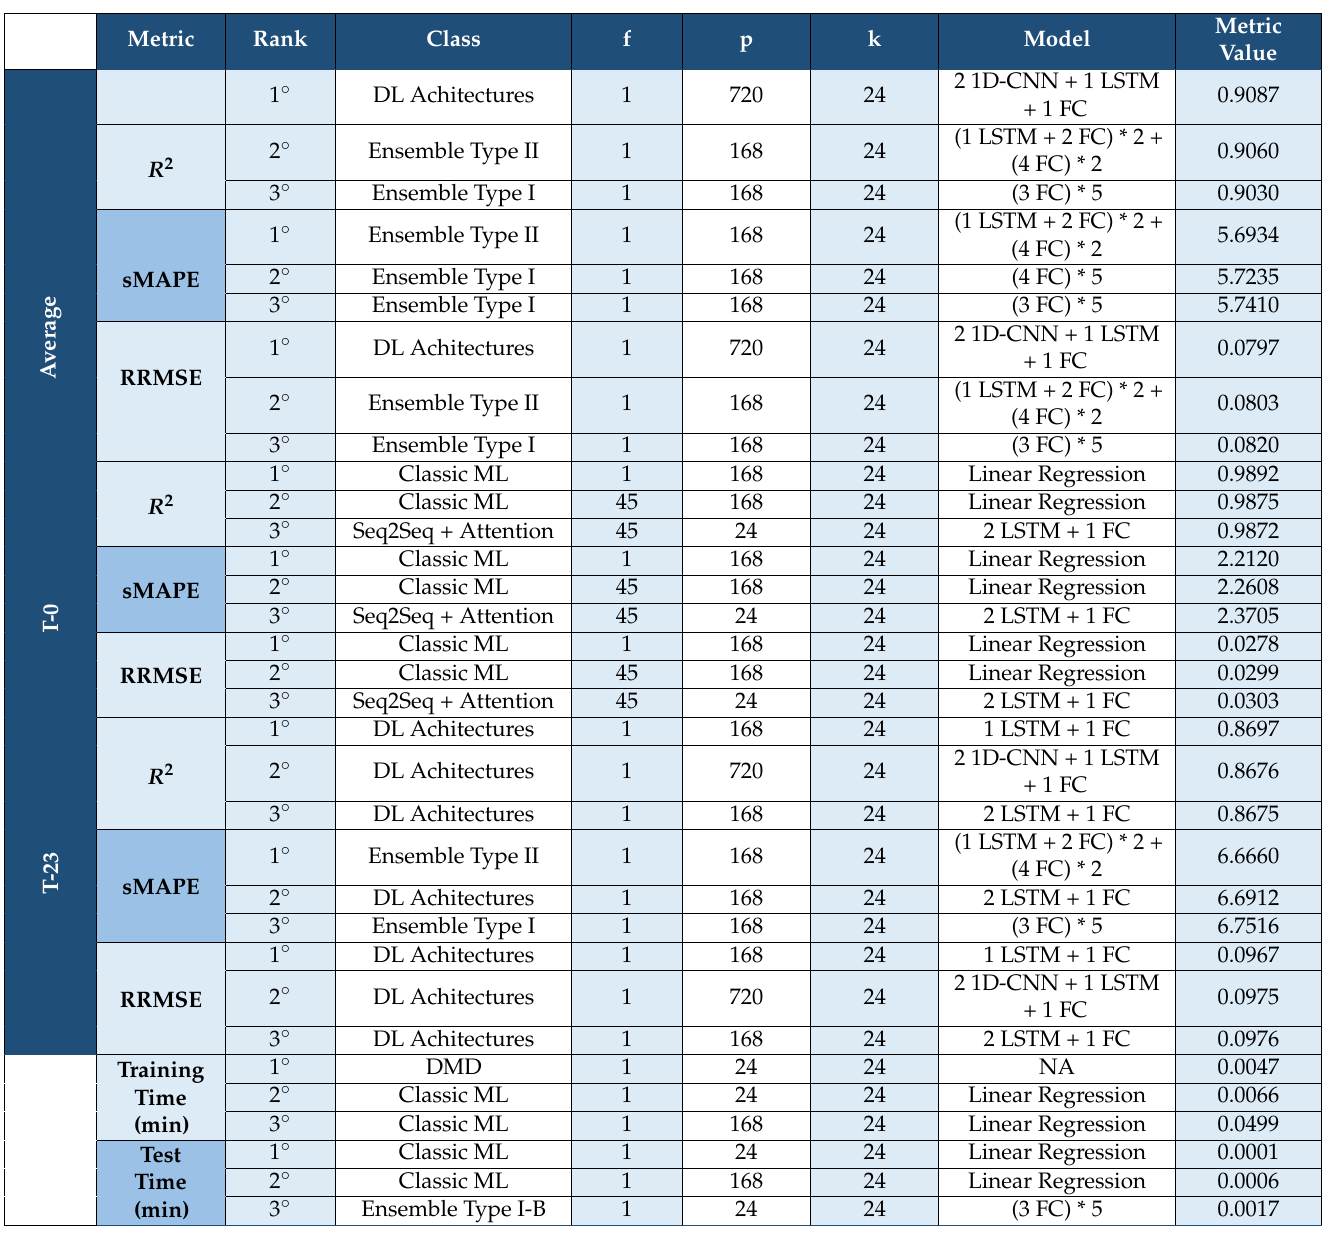
Table 1. Ranking of the three best models for the three most important metrics ( R 2 , SMAPE and RRMSE) plus training and test times. Values are provided for the forecasts of the first (T-0) and the last (T-23) time-slots, in addition to the average of forecasts for all (24) predicted